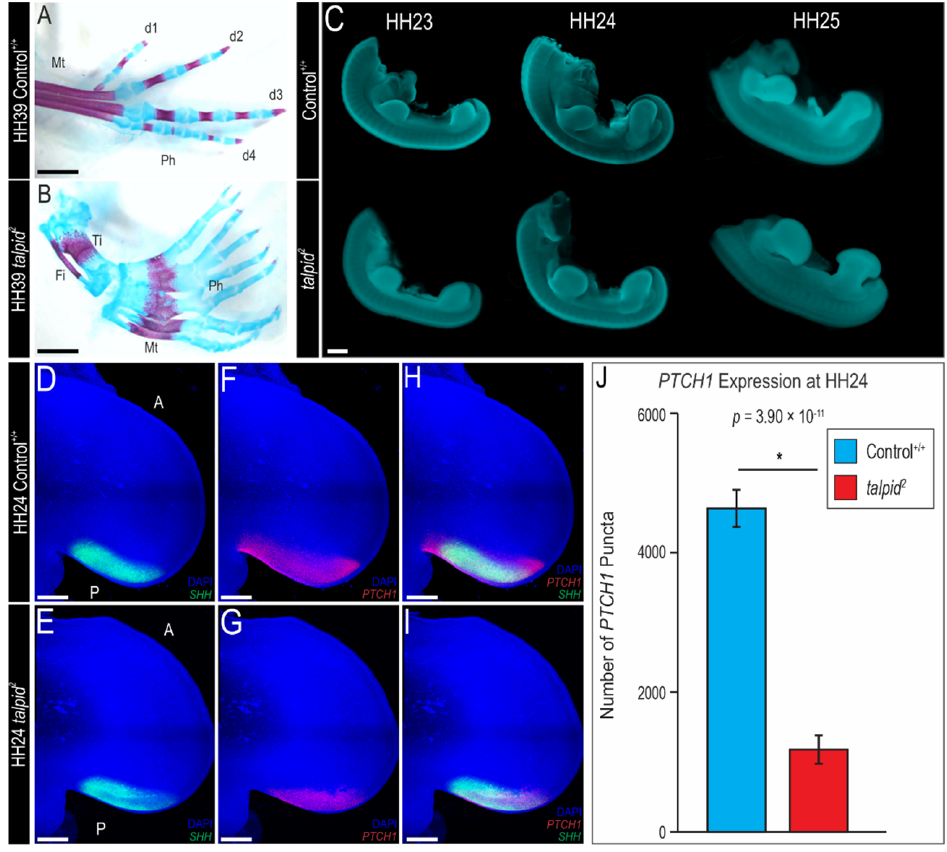
Figure 1. Polydactylous ta 2 phenotype does not correlate with PTCH1 expression. ( A , B ) Alcian blue and Alizarin red staining of a HH39 control +/+ ( n = 5) and ta 2 ( n = 4) hindlimbs. ( C ) Wholemount HH23-25 control +/+ and ta 2 embryos stained with DAPI. ( D – I ) RNAscope in situ hybridization for ( D , E ) SHH , ( F , G ) PTCH1 or ( H , I ) both SHH and PTCH1 in HH24 control +/+ ( n = 9) and ta 2 ( n = 9) hindlimbs. ( J ) Puncta quantification for PTCH1 expression in HH24 control +/+ and ta 2 hindlimbs. A: Anterior, D1–D4: digits, Fi: fibula, Mt: metatarsal element, P: posterior, Ph: phalanges, Ti: tibia. Scale bars: ( A , B ) 2 mm, ( C ) 1 mm, ( D – I ) 500 µ M. Error bars represent the mean data ± s.d. Statistical analysis was performed utilizing Student’s t -test (* denotes p <